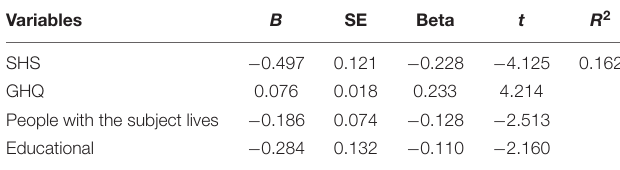
TABLE 8 | Regression model: Loneliness (UCLA) as dependent